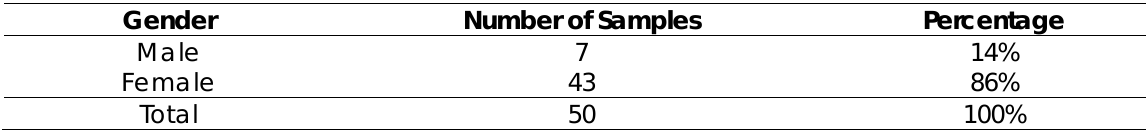
Distribution of Sample based on